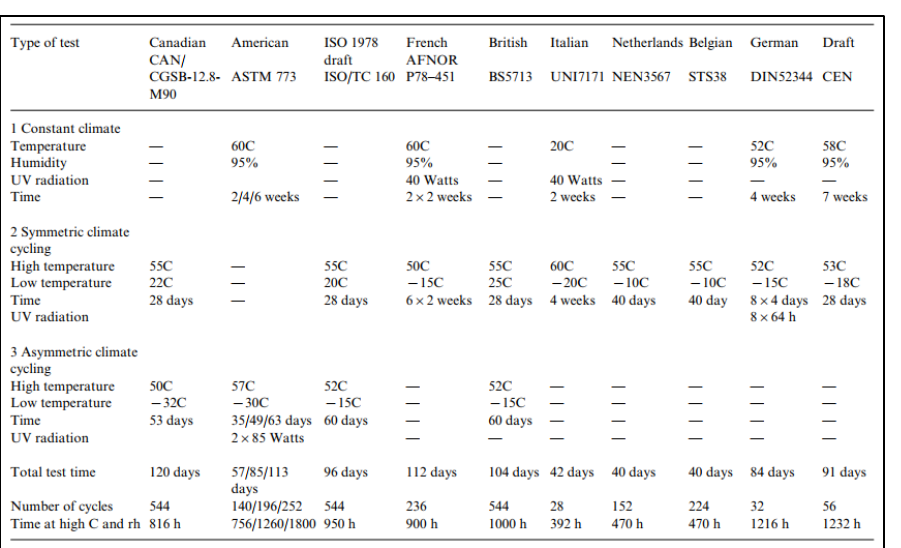
Figure 12. Standard Test Comparison